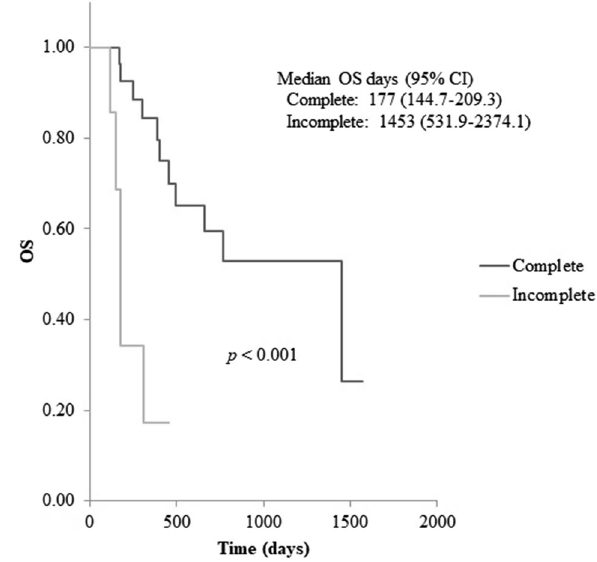
Figure 1. Kaplan–Meier analysis of overall survival (OS) since start of Ra-223 treatment between the complete and incomplete group. Kaplan–Meier analysis revealed significantly shorter OS for patients in the incomplete arm ( p < 0.001). CI; confidence